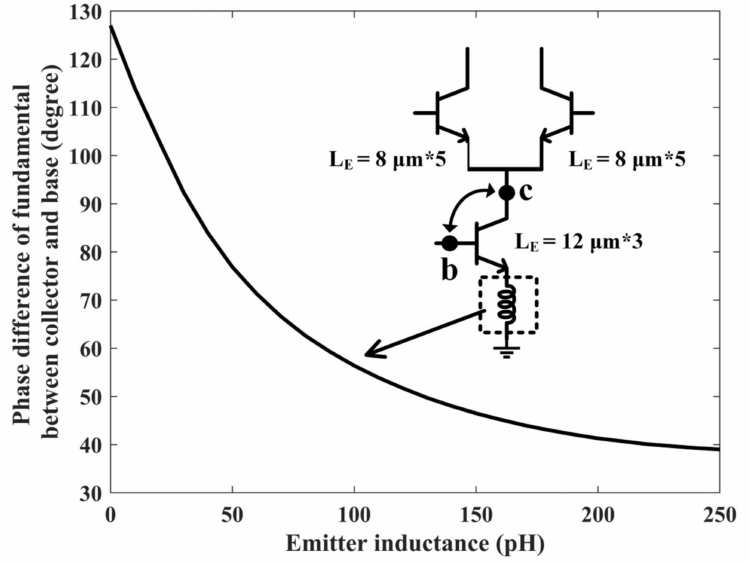
Figure 6. Phase difference of fundamental between collector and base in